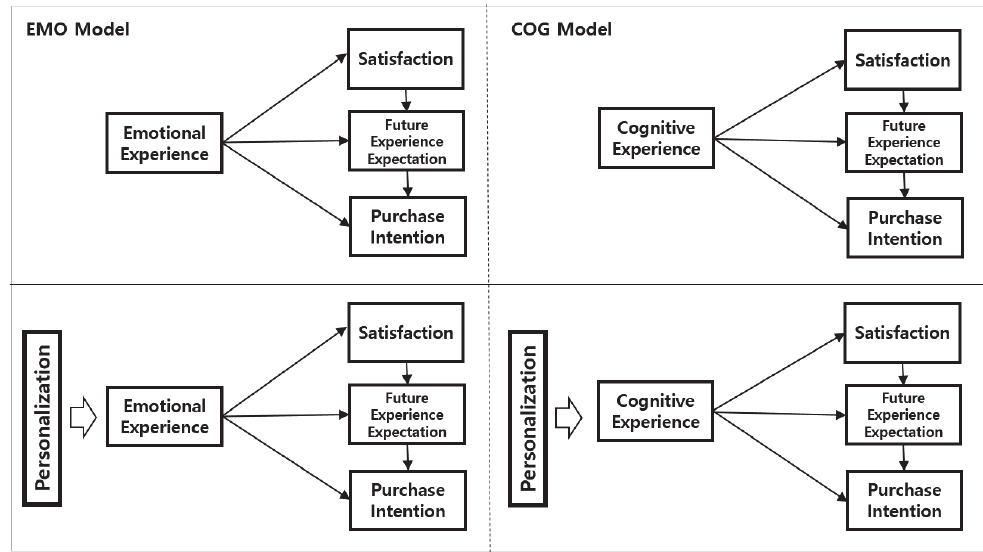
<Figure 4> Model: Before Personalization/After